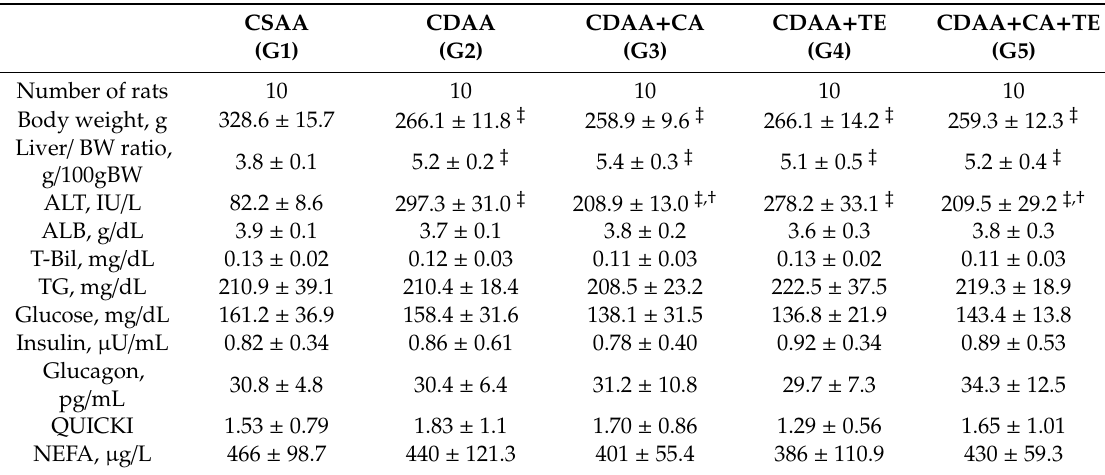
Table 1. Characteristics of the experimental groups in rats fed the CSAA-or CDAA